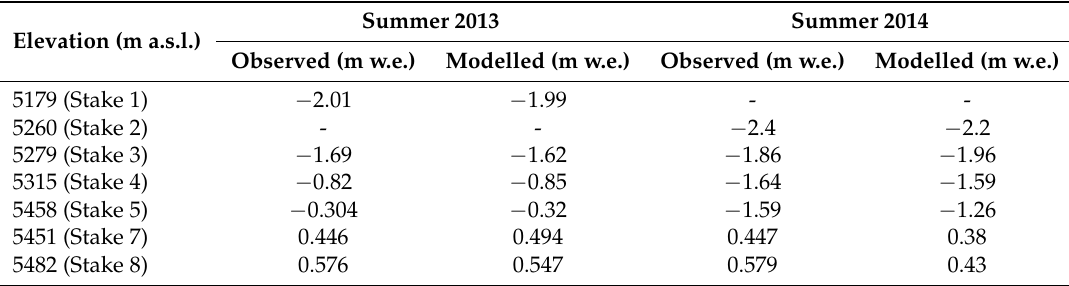
Table 5. Observed and modelled point mass balances for the summer of 2013 (8 May–19 November) and 2014 (5 May–15 November) at different stake locations.